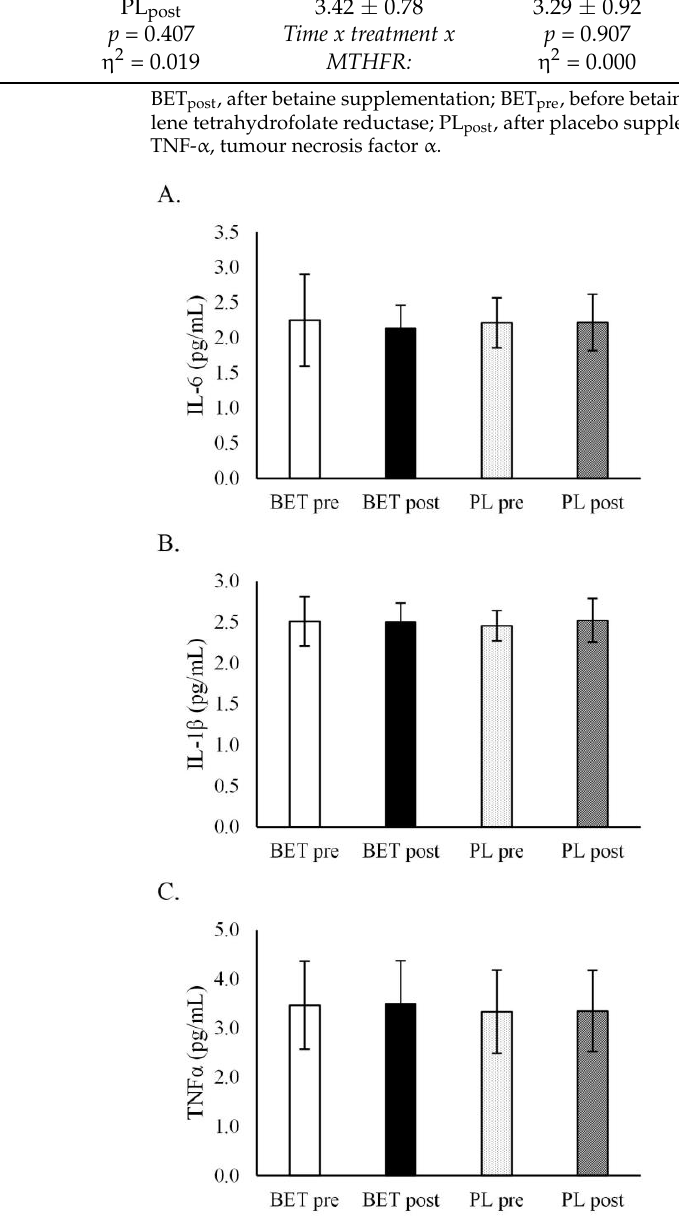
Figure 4. The effect of betaine supplementation on cytokines concentrations. ( A ). The effect of betaine supplementation on interleukin 6 concentration. ( B ). The effect of betaine supplementation on interleukin 1 β concentration. ( C ). The effect of betaine supplementation on tumour necrosis factor α concentration. BET post , after betaine supplementation; BET pre , before betaine supplementation; IL, interleukin; PL post , after placebo supplementation; PL pre , before placebo supplementation; TNF- α , tumour necrosis factor α